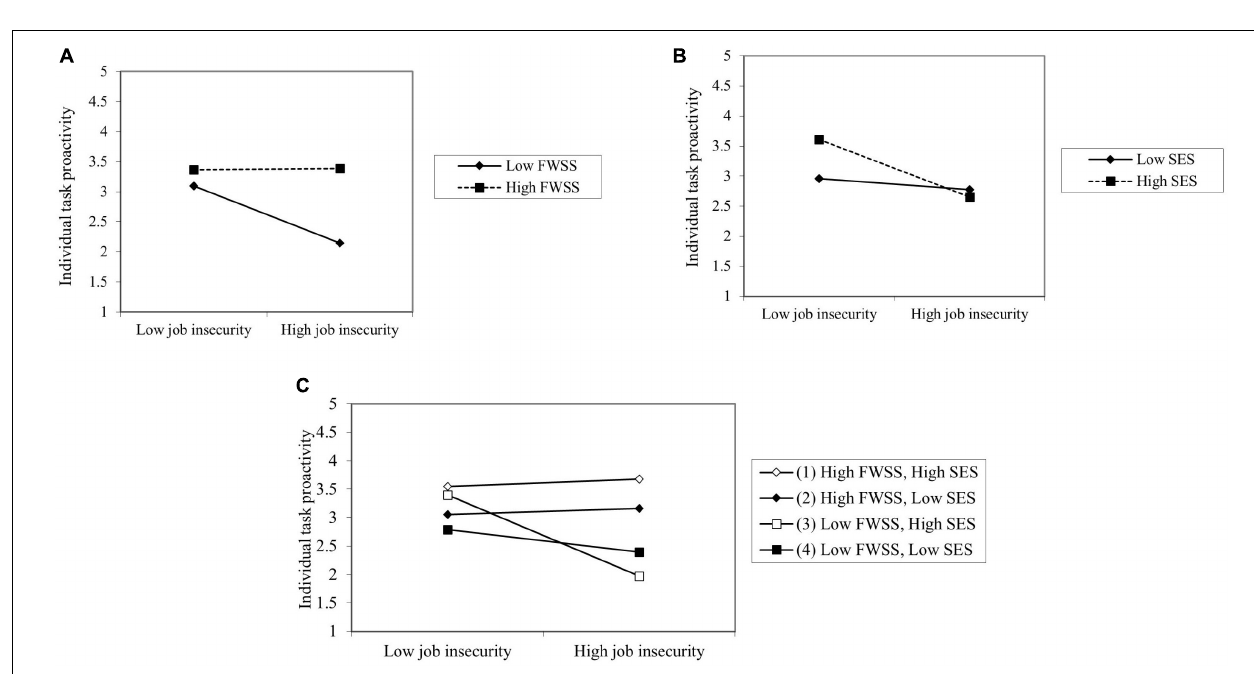
FIGURE 2 | The moderating role of FWSS and SES on the relationship between job insecurity and PSD. (A,B) Two-way interaction. (C) Three-way interaction.